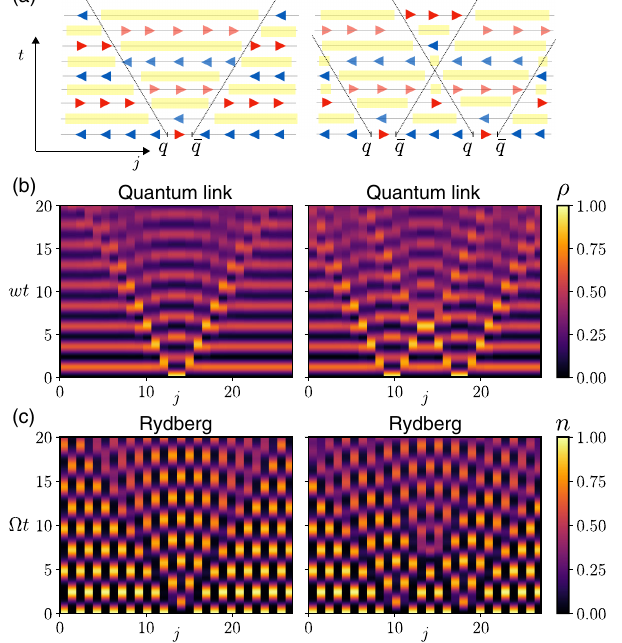
FIG. 5. Slow dynamics of particle-antiparticle pairs. (a) Illus- tration of the states involved in the propagation of particle- antiparticle pairs q − ¯ q . The notation is the same as in Fig. 1(c), while the yellow stripes denote regions of space with largest ˆ E ≃ 0 . (b): Evolution of the particle density and therefore h j;j þ 1 i particle density in the QLM starting from a bare vacuum or “ string ” state, see Fig. 1(c), with initial particle-antiparticle pairs. (c) Same as in (b), but in the Rydberg excitation density representation. Left-hand column: The oscillations observed in the light-cone-shaped region originating from the particles is observed to be out of phase with respect to those of the bare vacuum. Right-hand column: In the presence of two q − ¯ q pairs, an additional change of periodicity is expected in correspondence of elastic scattering. In these simulations, m ¼ δ ¼ 0 .